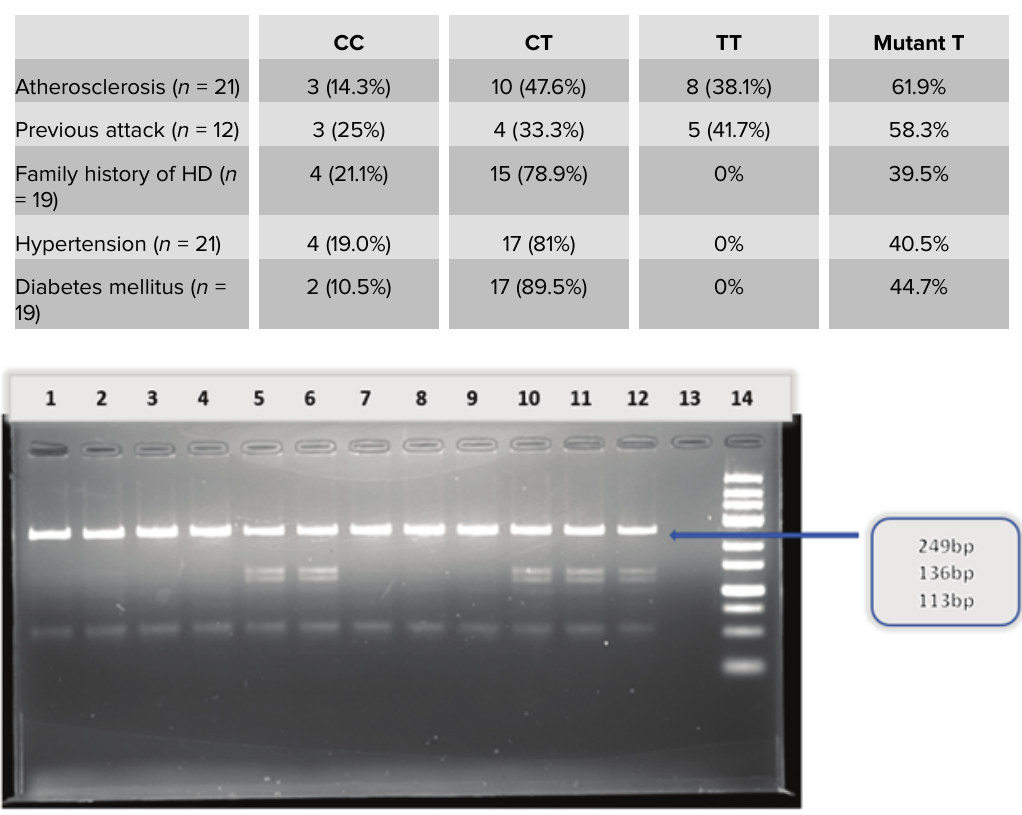
TABLE 4: Frequencies of genotypes and the mutant allele of IL1β C > T (rs1143634) polymorphism and the confounding factors in HD patients.